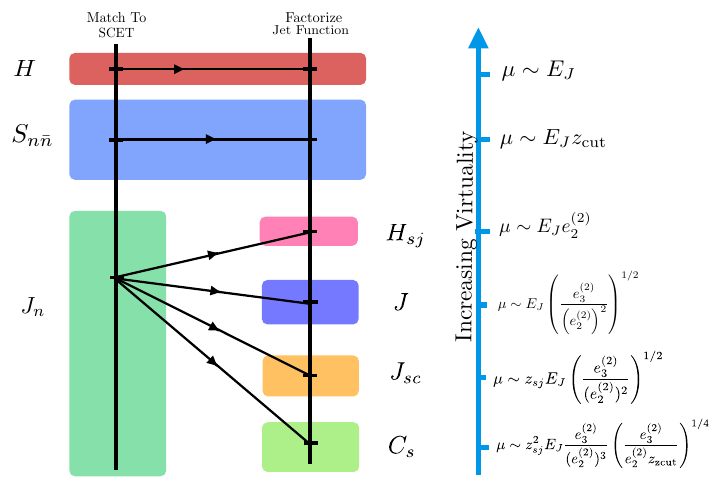
Figure 10. A schematic of the multistage matching procedure in the soft-collinear subjet region of phase space. The function incorporating non-global collinear e(cid:11)ects is not shown, but is discussed in the